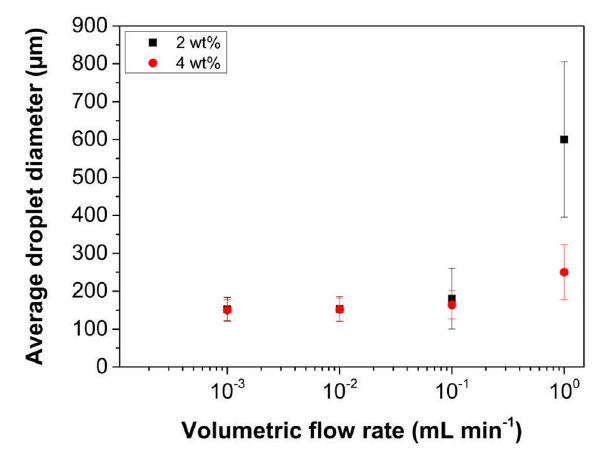
FIGURE 7 | Variation in mean droplet size of hexadecane in water emulsions as a function of oil injection rate at 2 and 4 wt% particle loading of LP-DMAEMA 245 . The continuous phase contained an electrolyte concentration of 0.01M KNO 3 at pH 9. The membrane rotation speed was fixed at 1,000